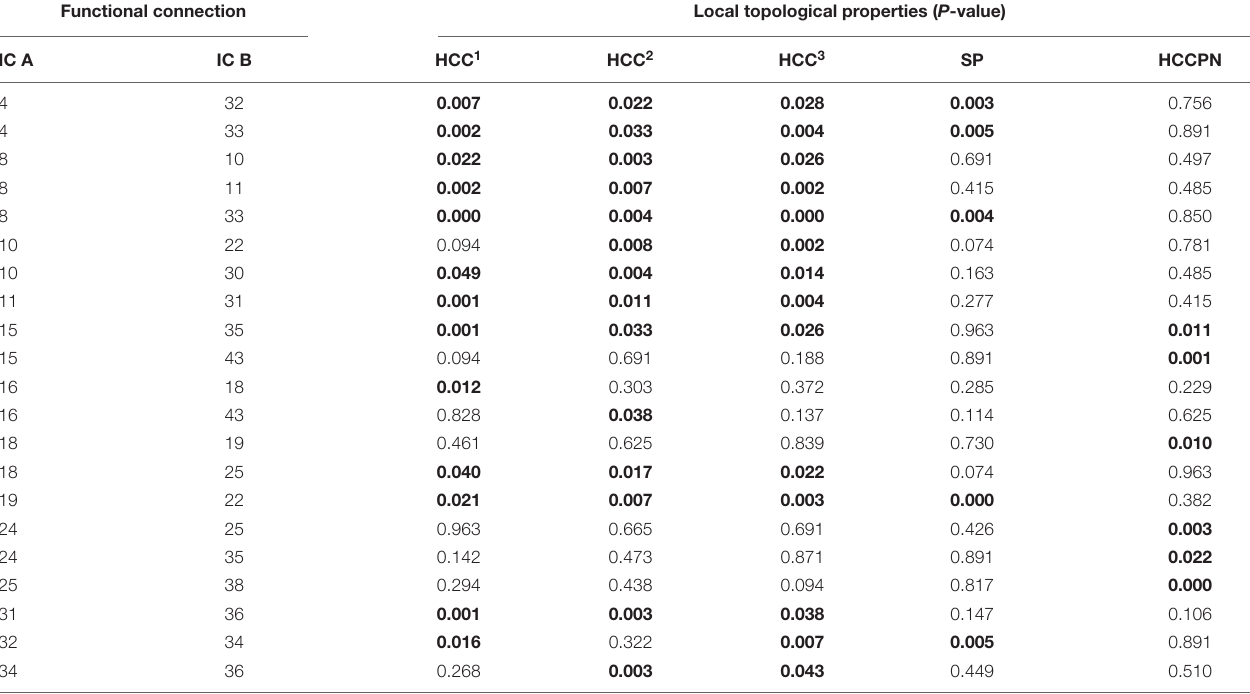
TABLE 2 | Discriminative functional connectivity based on local attributes. Functional connection